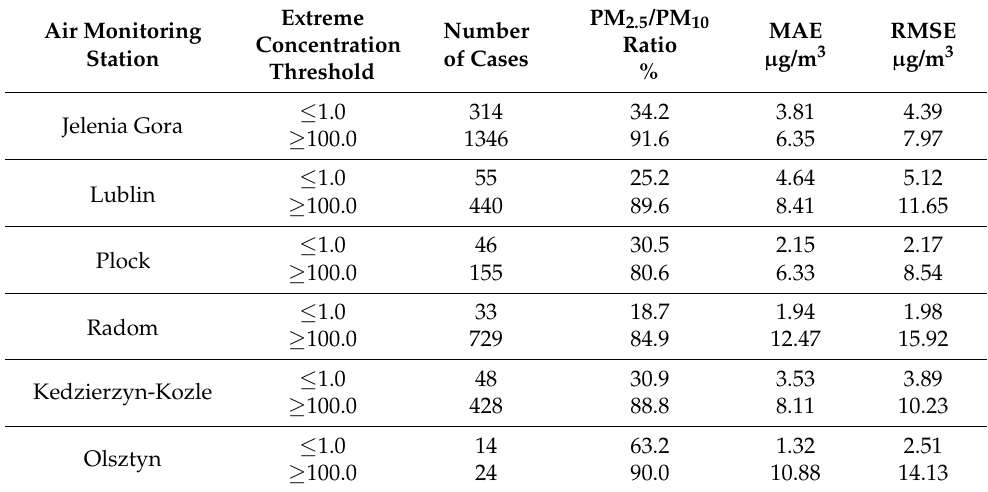
Table 6. Modeling errors and some statistics in the extreme low and high ranges of PM 2.5 concentra- tions at different air monitoring stations (variant MLP